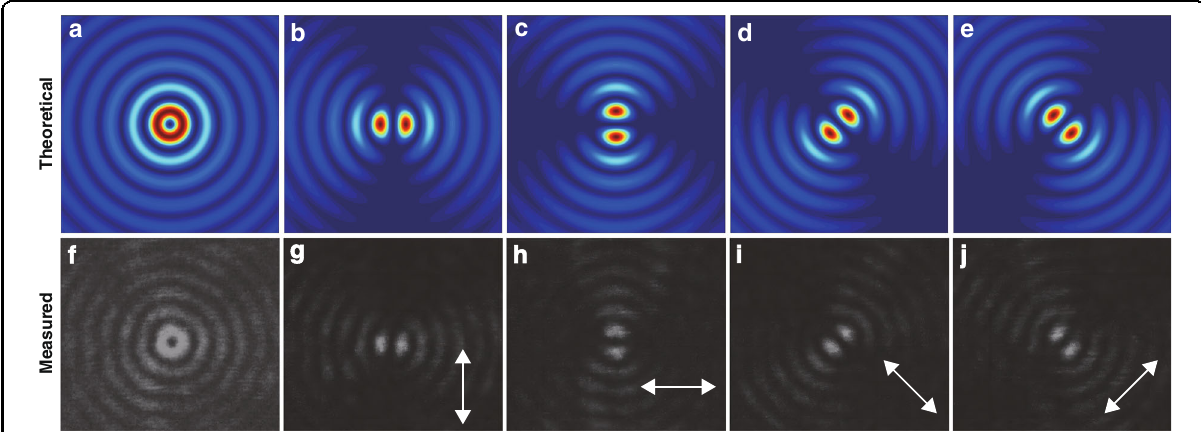
Fig. 2 The polarization characteristics of BGb generated by the integrated photonic chip. a The far- fi eld light intensity distribution, b – e under different polarization states, theoretically. f Measured intensity distribution at a distance of 2.2 m from the chip surface, g – j after a polarizer in the directions indicated by the